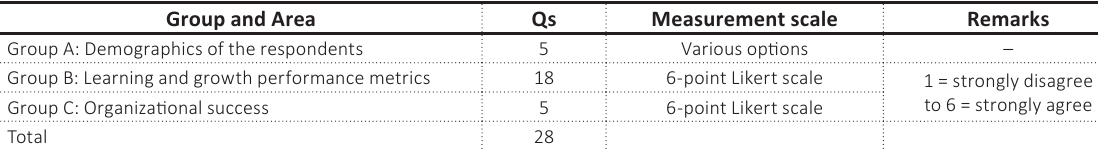
Table 1. Questionnaire structure Group and Area